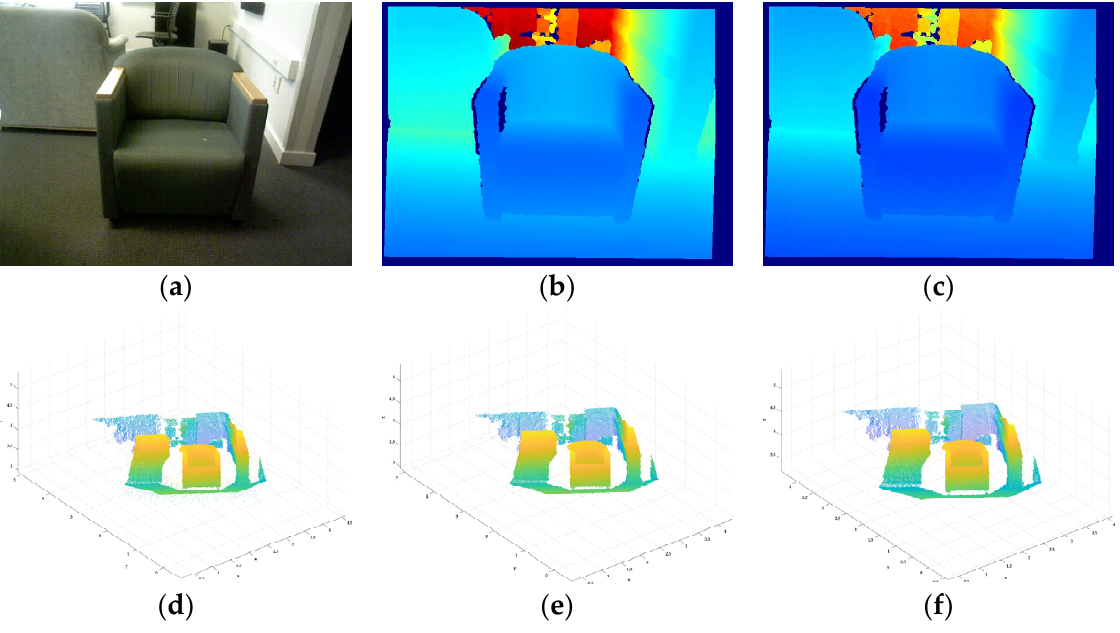
Figure 6. Denoising effect of fractional integral denoising and median filtering. ( a ) RGB image (dataset number 00033); ( b ) deep pseudo-colour map (dataset number 00033); ( c ) noise-free point cloud image; ( d ) point cloud image with added noise, PSNR = 46.58 dB; ( e ) point cloud image filtered by fractional integral denoising ( ν = − 0.3, PSNR = 52.509 dB); and ( f ) point cloud of the depth image after median filtering and denoising (PSNR = 39.141 dB).